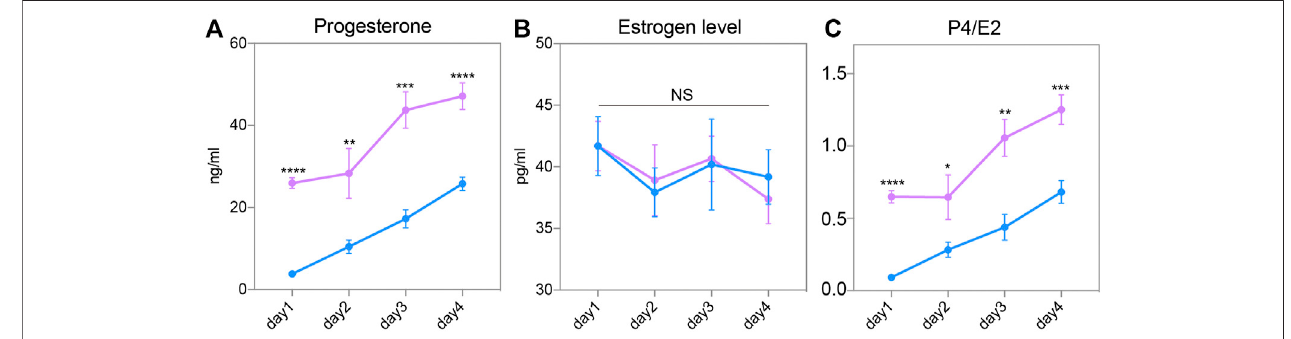
FIGURE 4 | Steroid hormone in response to superovulation. (A) Circulating progesterone (P4) levels in the control (blue) and superovulation (magenta) groups. (B) Circulating estrogen (E2) levels in the control (blue) and superovulation (magenta) groups. (C) The ratio of P4/E2 in control (blue) and superovulation (magenta) groups. The results are shown as means ± SEM. * p < 0.05, ** p < 0.01, *** p < 0.001, **** p < 0.0001. n ≥ 5.